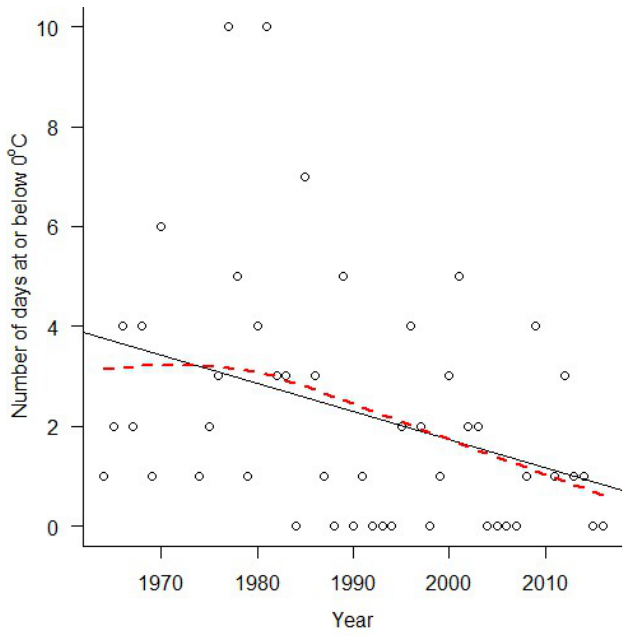
Figure 4. Frost events over time. The number of days per year where the temperature drops below freezing (0 °C) is decreasing over time in Central Florida. Data was obtained from the Florida Climate Center’s website, collected at the Orlando International Airport from 1964 through 2016. This figure excludes 2010, an extreme outlier with 13 days below freezing, due the “polar vortex”. The pattern is similar, though not significant when 2010 is included in the analysis. The red dotted line was added using LOESS with a span of 2 for visualization purposes due to violations of the assumptions of simple linear regression.